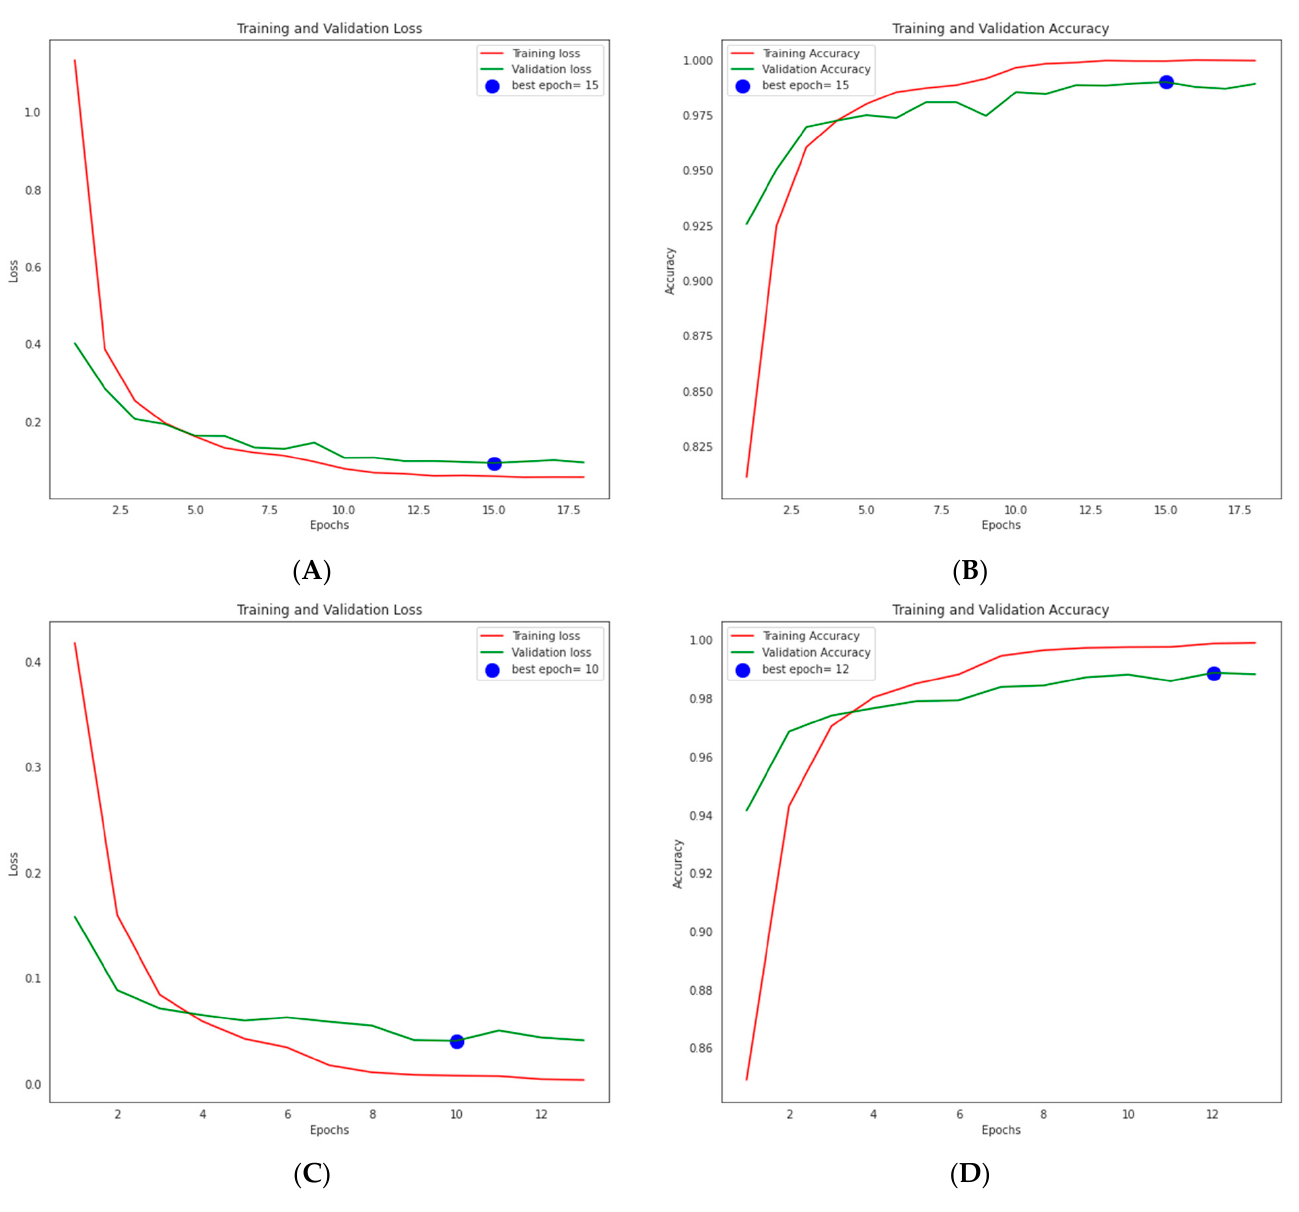
Figure 7. Training and validation accuracy and loss of ( A , B ) the EfficientNetV2S model and ( C , D ) the ensemble model. Table 1. Full training procedure of both models with training and validation